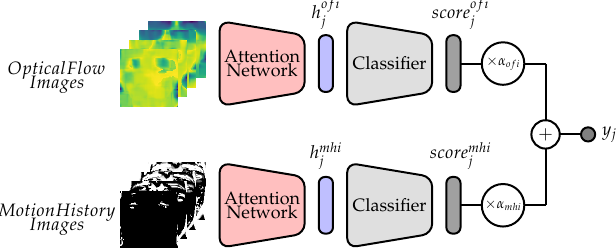
Figure 2. Two-Stream Attention Network with Weighted Score